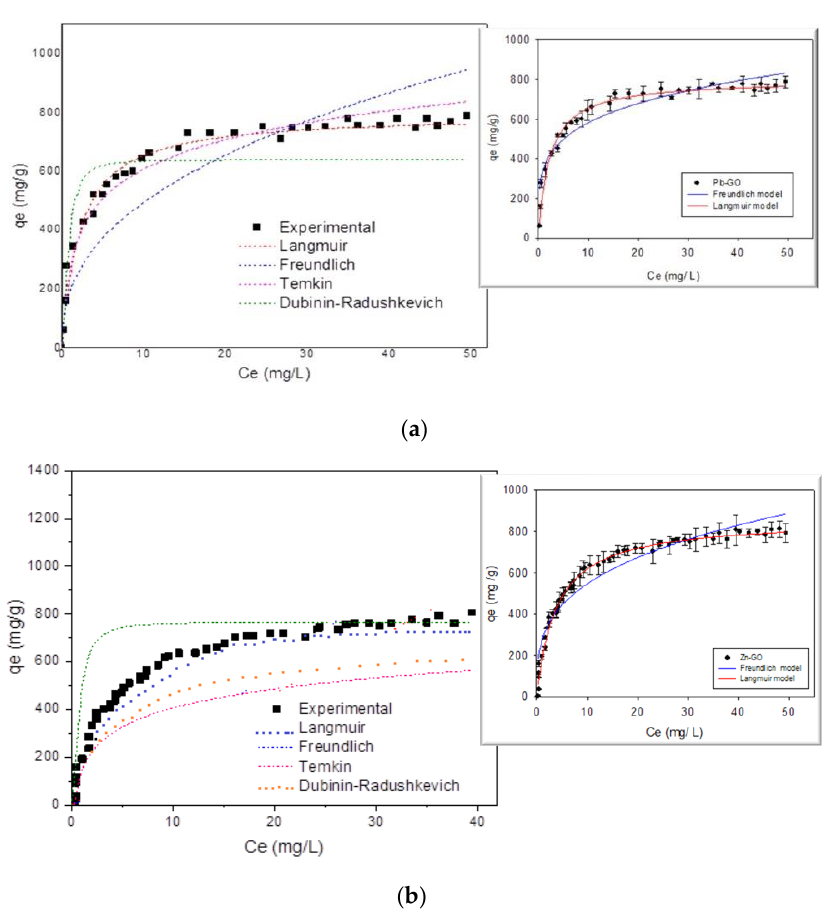
Figure 11. Adsorption isotherms of Pb(II) and Zn(II) ions on GO: ( a ) Pb on GO ( b ) Zn on GO. Table 4. Comparison of adsorption capacities with other adsorbents involving graphene oxide and other related